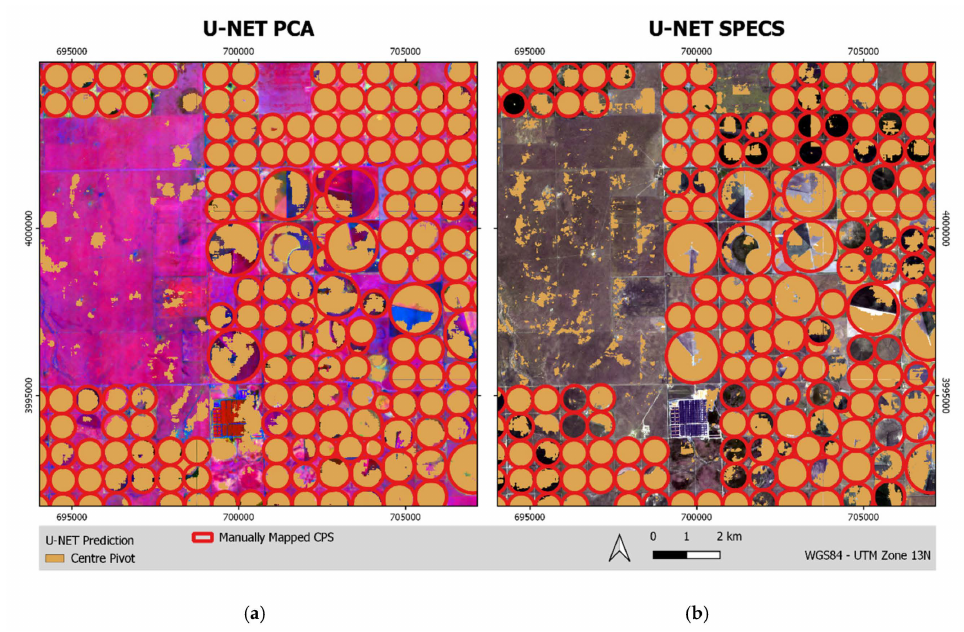
Figure 4. Semantic segmentation results (orange) of U-NET PCA ( a ) and U-NET SPECS ( b ) for the validation area part of the Texas site. The manually mapped CPSs are displayed in red. In addition, the first three principal components are shown for U-NET PCA and the Sentinel-2 bands 2, 3, and 4 for U-NET SPECS in the background.